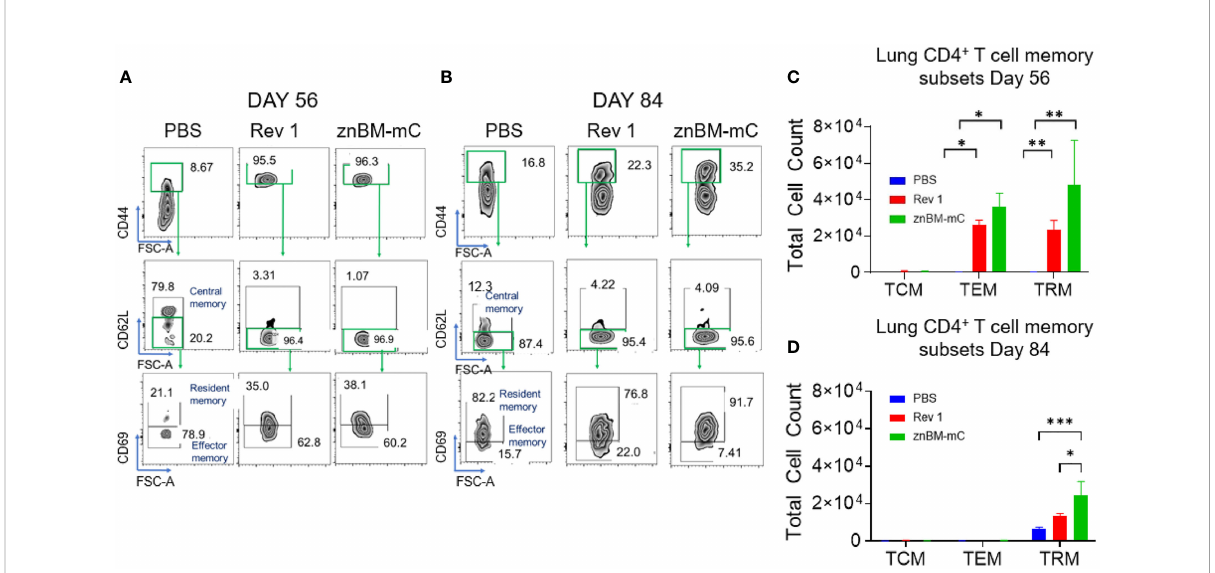
FIGURE 8 Mucosal vaccination with znBM-mC induces lung memory CD4 + T cells comprised of both TEMs and TRMs. Groups of BALB/c mice (10-14/ group) vaccinated with PBS, Rev 1, or znBM-mC, and then challenged as previously described. (A) Pre- (day 56) and (B) post-challenge (day 84) lung lymphocytes were isolated and restimulated with Ag overnight as described in Figure 7. FACS plots depict (A) day 56 and (B) day 84 noncirculating memory lung CD4 + T cells from mice vaccinated with PBS, Rev 1, or znBM-mC. (C) Total numbers of pre-challenge and (D) post-challenge lung CD4 + TCM, TEM, and TRM subsets are depicted. Data are representative of two experiments. Two-way analysis of variance followed by Turkey ’ s multiple comparisons test was performed; *p < 0.05, **p < 0.005, and ***p < 0.0005 vs. PBS-dose